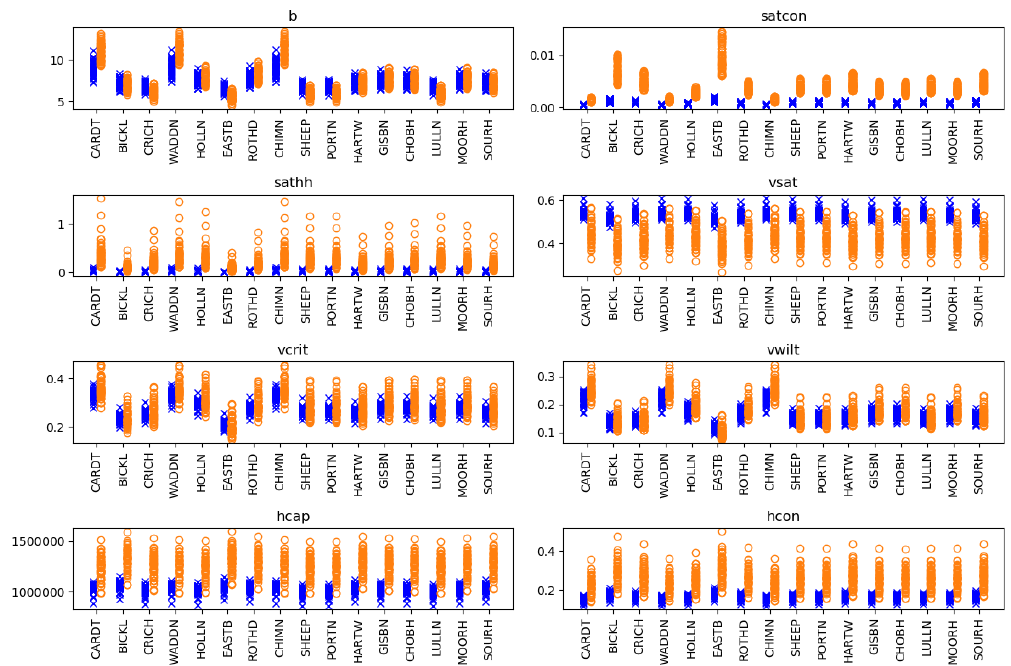
Figure 9. Ensemble prior (orange) and posterior (blue) parameter values at each site. These are “subsoil” results, which we have assumed to correspond to the deeper two soil layers in JULES (35–300cm depth from the surface).